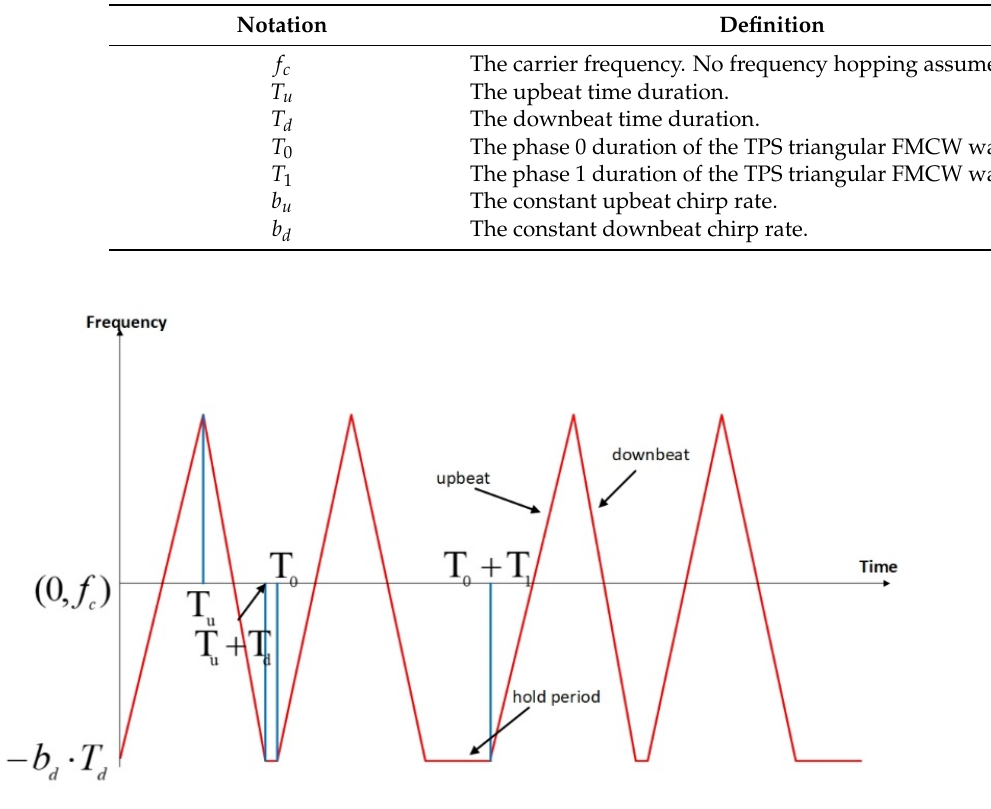
Figure 4. The two-phase staggered (TPS) triangular frequency modulated continuous wave (FMCW) waveform. Table 1. Notations of the TPS triangular FMCW waveform.